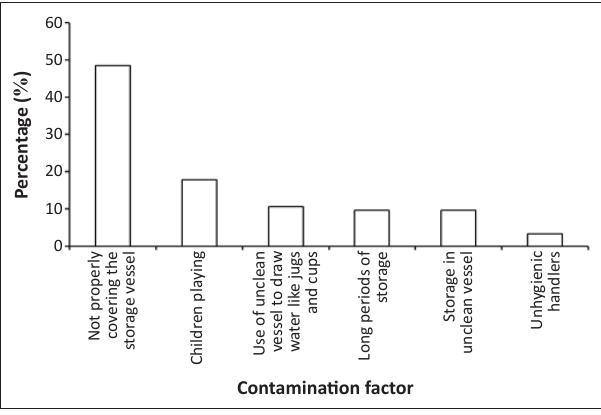
FIGURE 5 : Factors perceived to be the key causes of water contamination at household